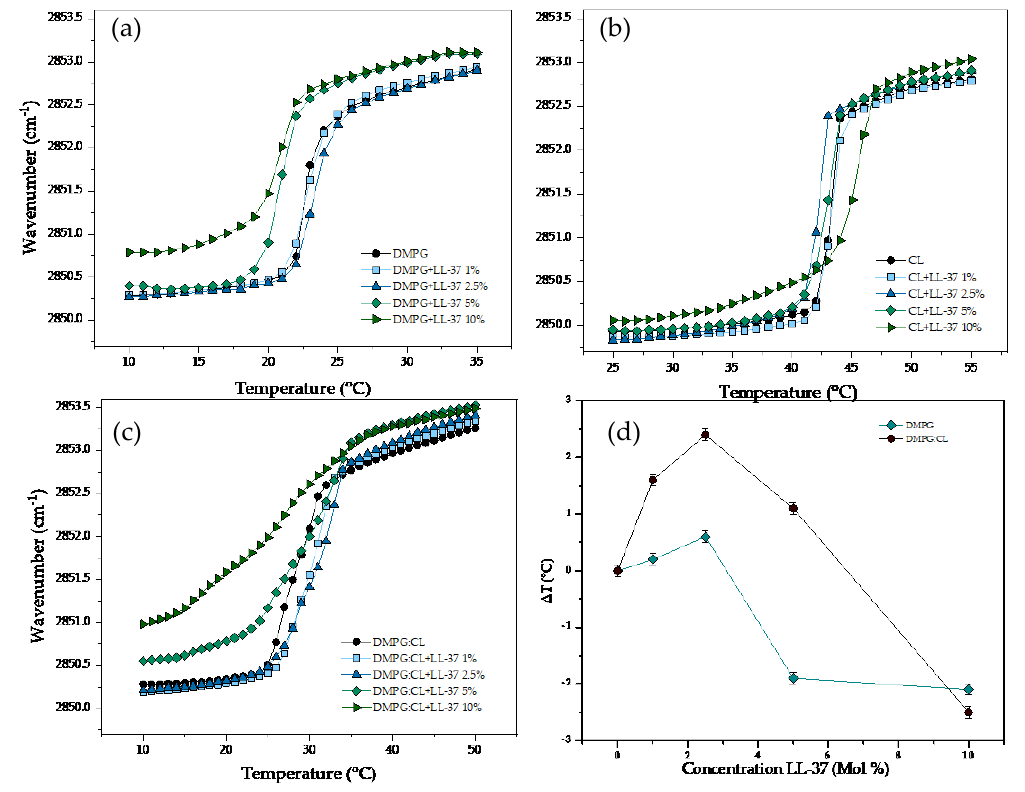
Figure 5. Peak positions of the symmetric stretching vibration bands of the methylene groups in dependence on temperature. Different concentrations of LL − 37 in supported lipid bilayers of ( a ) DMPG, ( b ) CL and ( c ) DMPG:CL. ( d ) Change of T m ( T) in the DMPG and DMPG:CL.